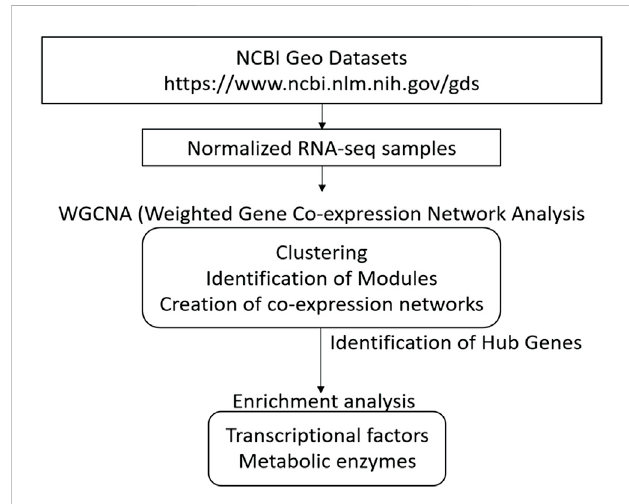
FIGURE 1 Overview for conducting Weighted Correlation Network Analyses (WGCNA) of different strains of Bi fi dobacterium genus using several HMOs. This schematization represents all steps since acquisition of